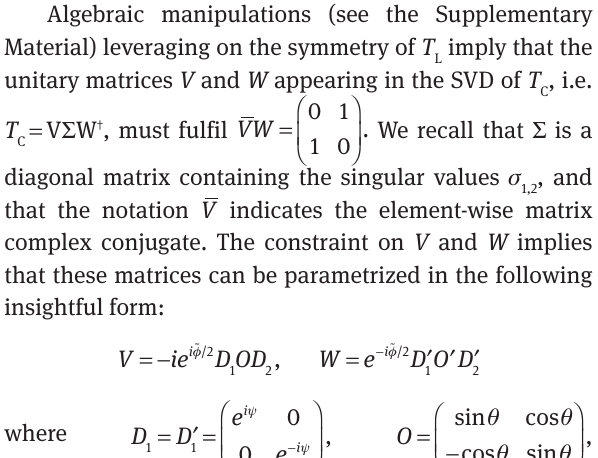
(figure inset). In the graph, the colored area indicates the accessible values of ˆ C for the present structure. Superchi- ral behavior occurs at wavelengths corresponding to the spectral features observed in the far-field transmission (see Figure 1C). Noticeably, maximum (minimum) values of ˆ C are not always achieved upon right (left) circularly polarized illumination, as it can be observed from the corresponding traces (blue and red curves,